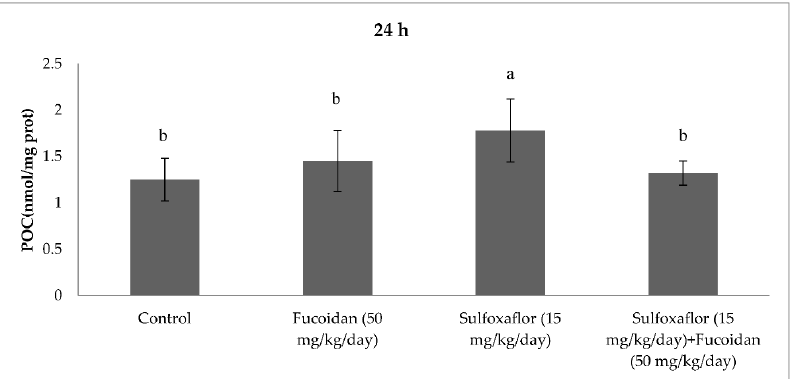
Figure 4. Effects of Sulfoxaflor and Fucoidan on MDA Levels (µmol/L) in Serum of Mice at 7-d Treatment Periods. Values are expressed as mean ± standard error. MDA: Malondialdehide. Letters a, b and c show the differences between treatment groups and control. Data shown in different letters are significantly different at p < 0.05 level ( n = 8). Duncan multiple comparison tests were used.